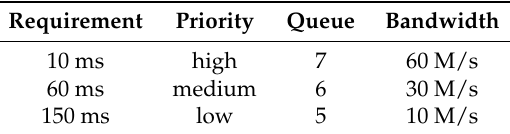
Table 3. Delay requirements.